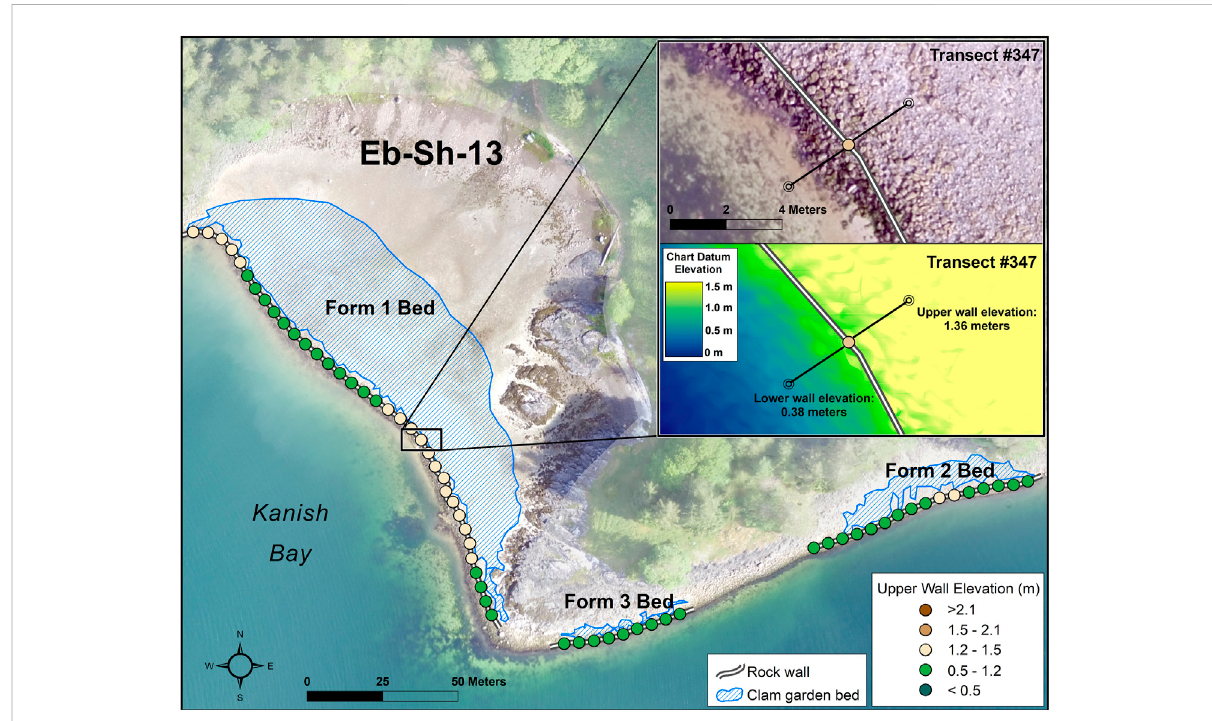
FIGURE 4 Site Eb-Sh-13, showing imagery and elevation model used to create sampling